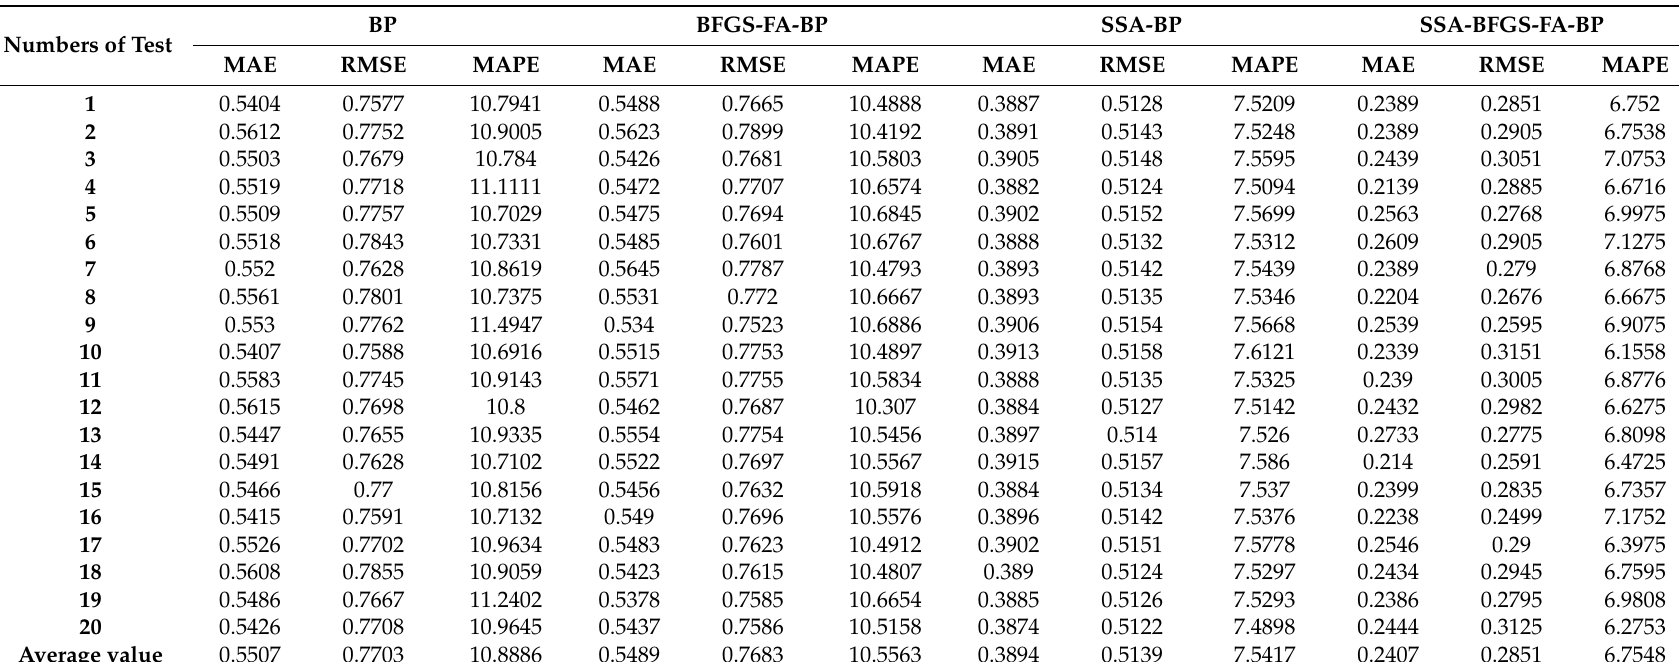
Table 9. MAE, RMSE, and MAPE of site 3 for each forecasting